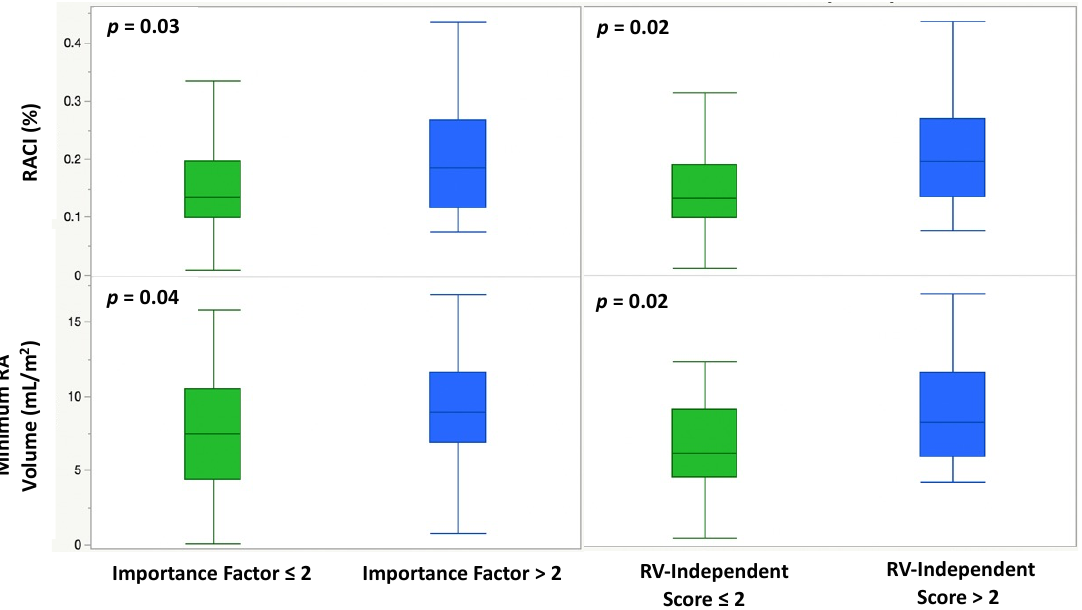
Figure 5. Box-and-whisker plots demonstrating the association of a high-risk Importance Factor Score (>2) and a high-risk RV-Independent Score (>2) with RACI (%) and indexed minimum RA volume (mL/m 2 ).